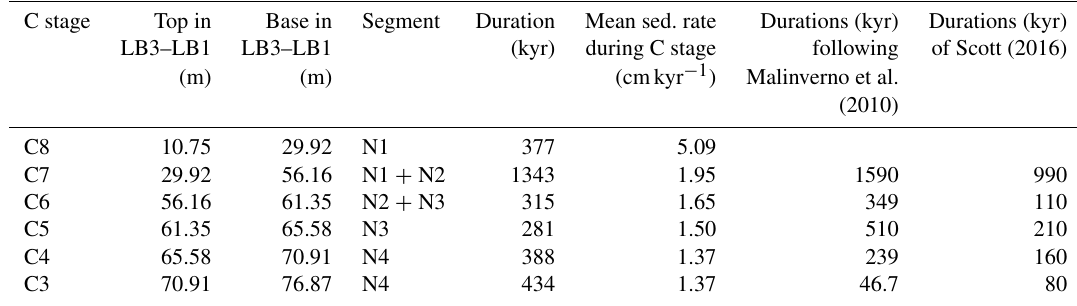
Table 3. Durations of individual phases for OAE2 in Tarfaya Basin Core SN ◦ 4 and comparison with Li et al. (2017b) and Gangl et al. (2019). Phases SN ◦ 4 (Tarfaya Basin, Gongzha section Sawpit Gully section SW Morocco; this study) (Tibet; Li et al., 2017b) (New Zealand; Gangl et al., 2019) Precursor 126kyr (last two prominent minima: 75kyr) 50 ± 25kyr (stage 2) 50kyr Onset 68kyr 110 ± 25kyr (stage 3a) 30 ± 13kyr Peak 86kyr 170 ± 25kyr (stages 3b + c) Plateau 204kyr 370 ± 25kyr (stage 4) Recovery 435kyr